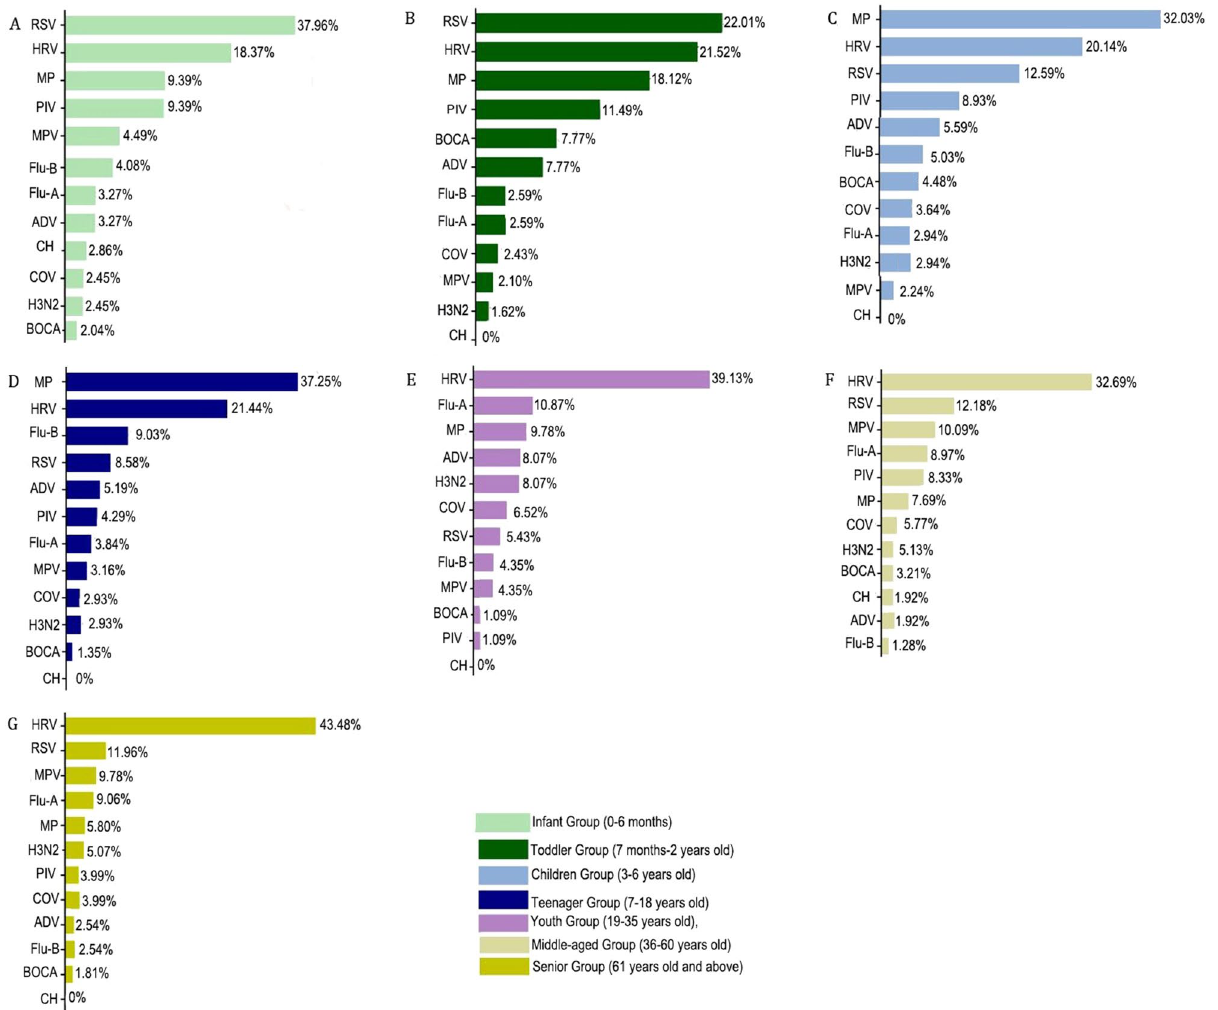
Figure 3. Detection of respiratory pathogens in different age groups after the COVID-19 pandemic. ( A ) The infant group. ( B ) The toddler group. ( C ) The children group. ( D ) The teenager group. ( E ) The youth group. ( F ) The middle-aged group. ( G ) The senior